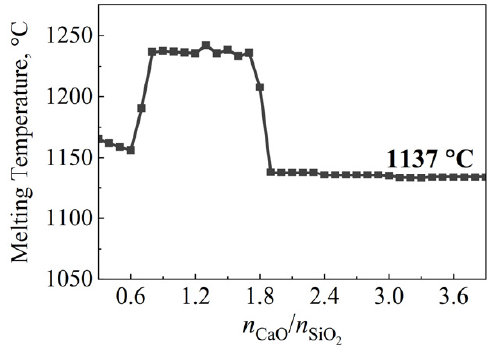
Figure 15. The onset melting temperature of the mixed system of iron oxide and gangue.